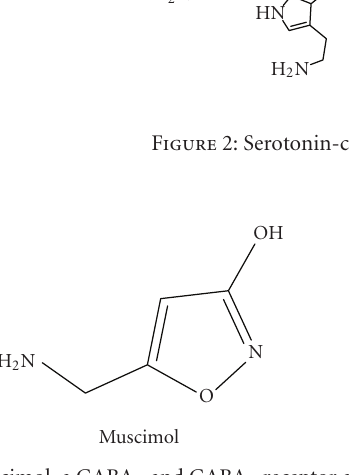
Figure 3: Muscimol, a GABA C and GABA A receptor